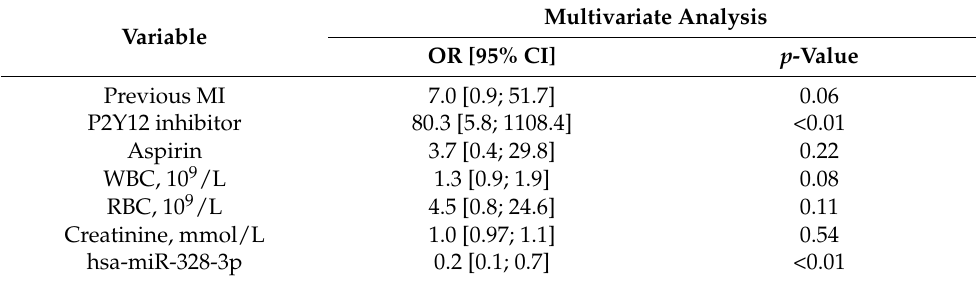
Table 5. The multivariate logistic regression analysis of clinical variables and miRNA expression profile in Group 1 compared to Group 3 (Model